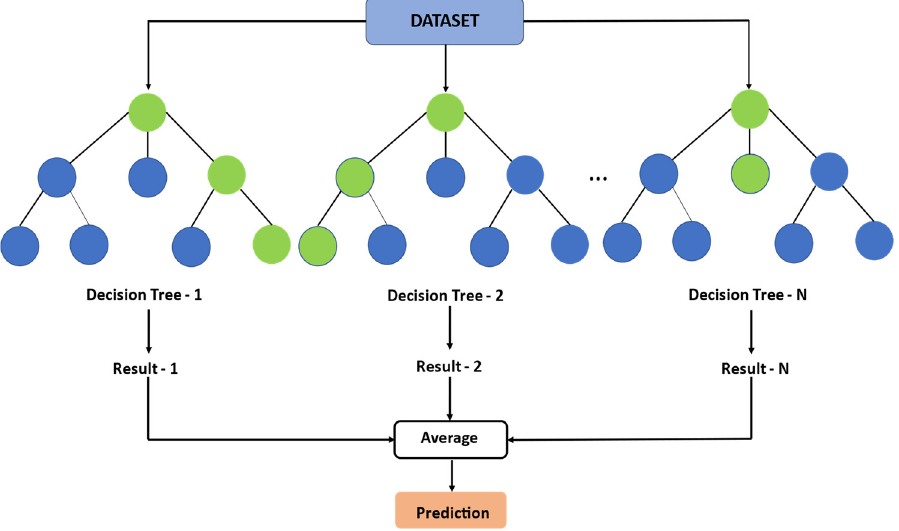
Figure 2. Algorithm for making predictions using random forest.